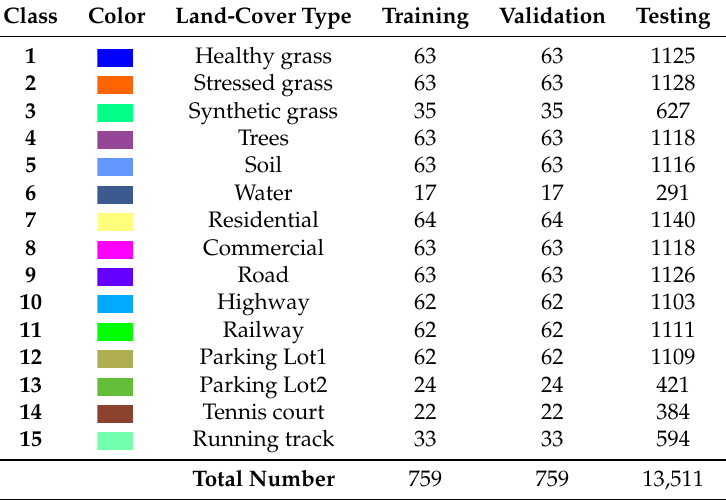
Table 4. Number of samples of the University of Houston (UH)